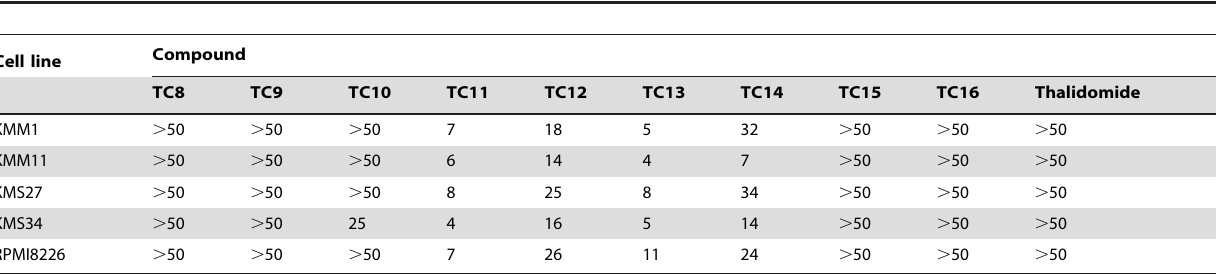
Table 1. IC 50 values ( m M) of thalidomide derivatives for inhibiting proliferation of multiple myeloma cell lines.